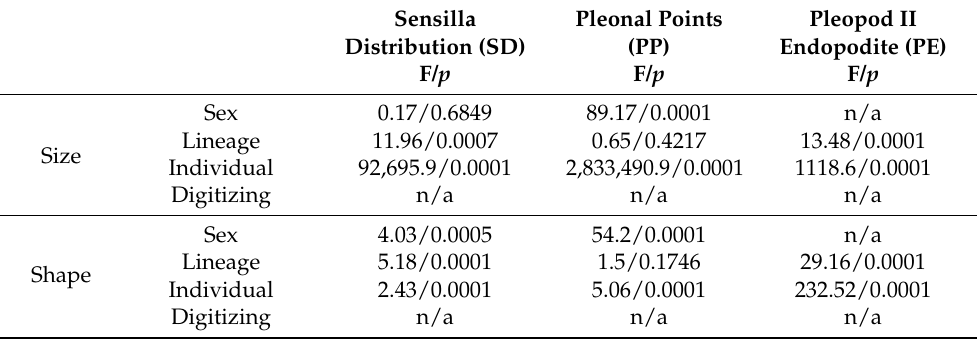
Table 2. Size and shape variation of sensilla distribution, pleonal points, and pleopod II endopodite inferred by Procrustes ANOVA where a randomized permutation procedure was applied (10,000 iterations). F: Goodall’s F critical value, p : probability of finding a randm value larger than the observed